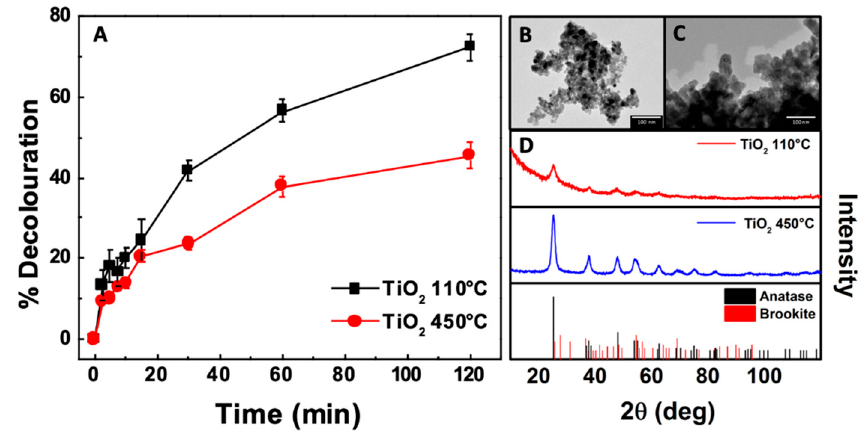
Figure 10. ( A ) TEM image of TiO 2 NPs calcined at 450 °C and comparison with TiO 2 _16 h ( B ). ( C ) XRD patterns of TiO 2 _16 h and TiO 2 _24 h. ( D ) Time course of the MB decolouration experiments under UV irradiation assisted by TiO 2 thermal treated at 110° C for 16 h (TiO 2 _16 h sample) and TiO 2 calcinated for 2 h at 450° (TiO 2 _450 °C).